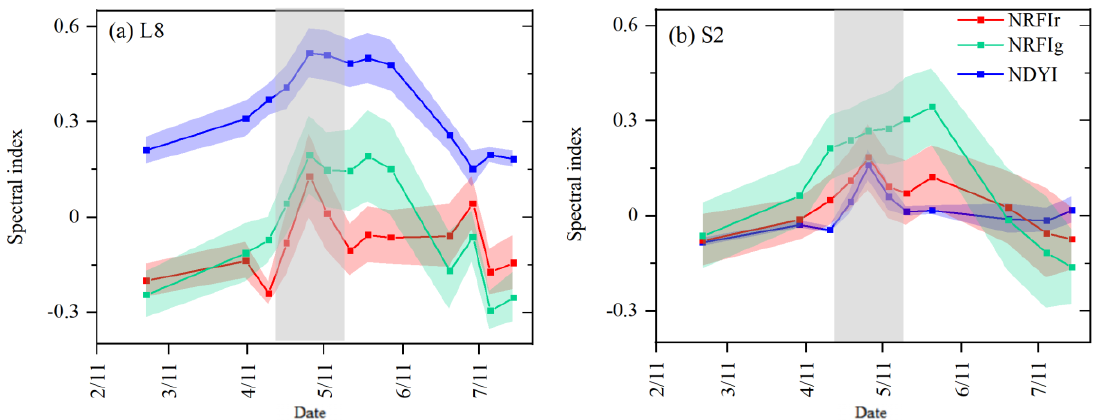
Figure 5. The time series of normalized difference yellow index (NDYI), NRFIr, and NRFIg at the 718 rapeseed parcels. ( a ) for L8; ( b ) for S2. The gray area indicates the flowering dates recorded by the DWD. Dots indicate the mean values, and the filled color areas indicate the standard deviations across the 718 parcels.